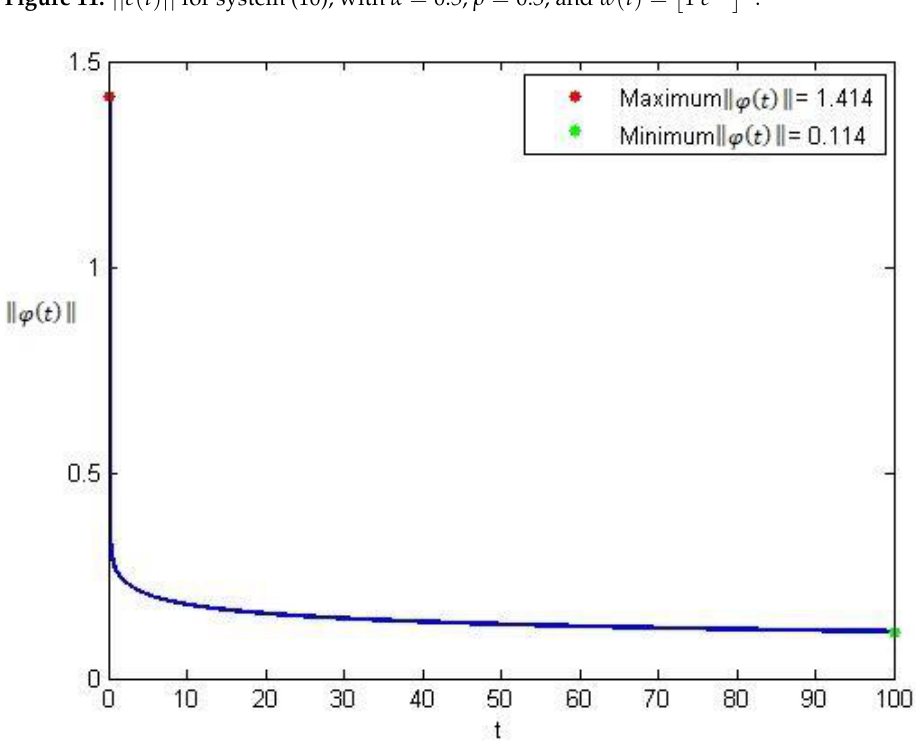
(cid:2) (cid:3) T 1 e − t .